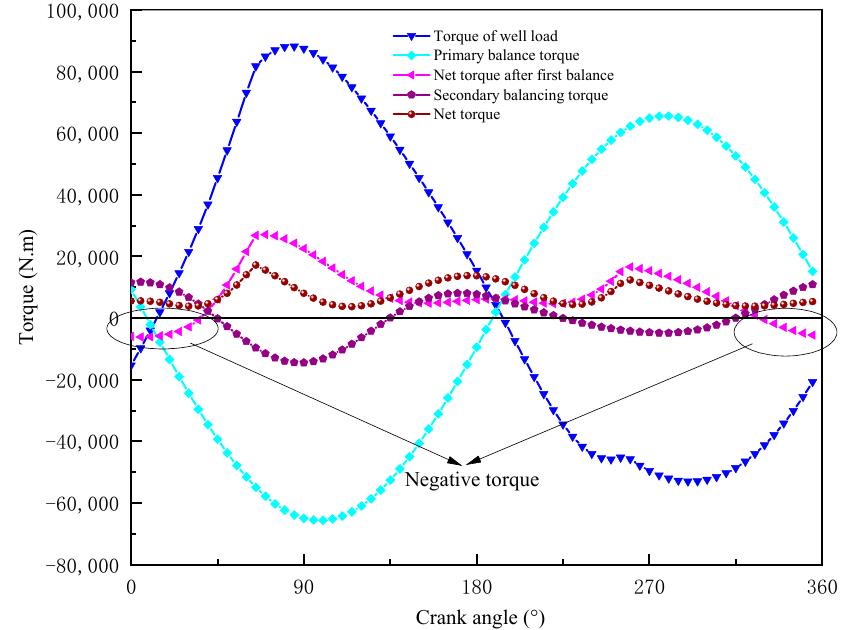
Figure 13. The torque superposition curve on the output shaft of gear box.